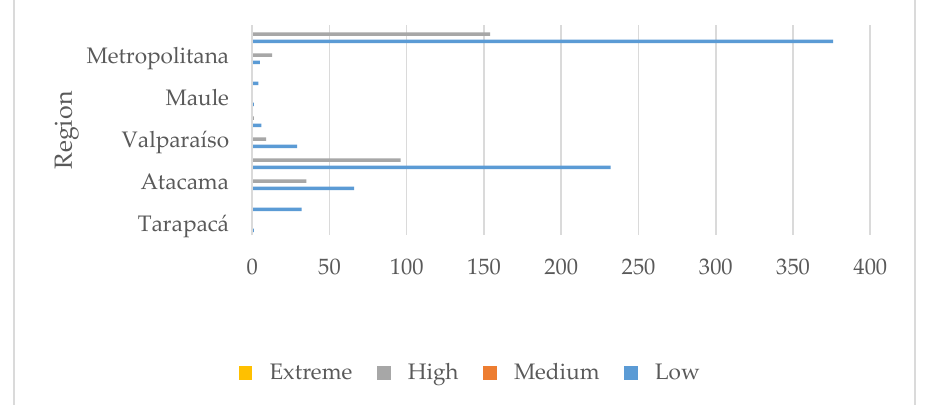
Figure 7. Distribution of regional tailings assessed according to heavy metals and water bodies.